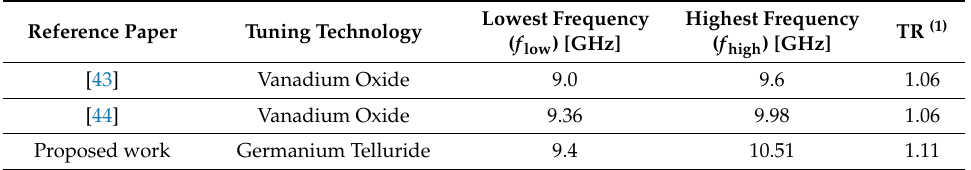
Table 1. Comparison table of the proposed frequency reconfigurable absorber using GeTe and other frequency reconfigurable absorbers using VO 2